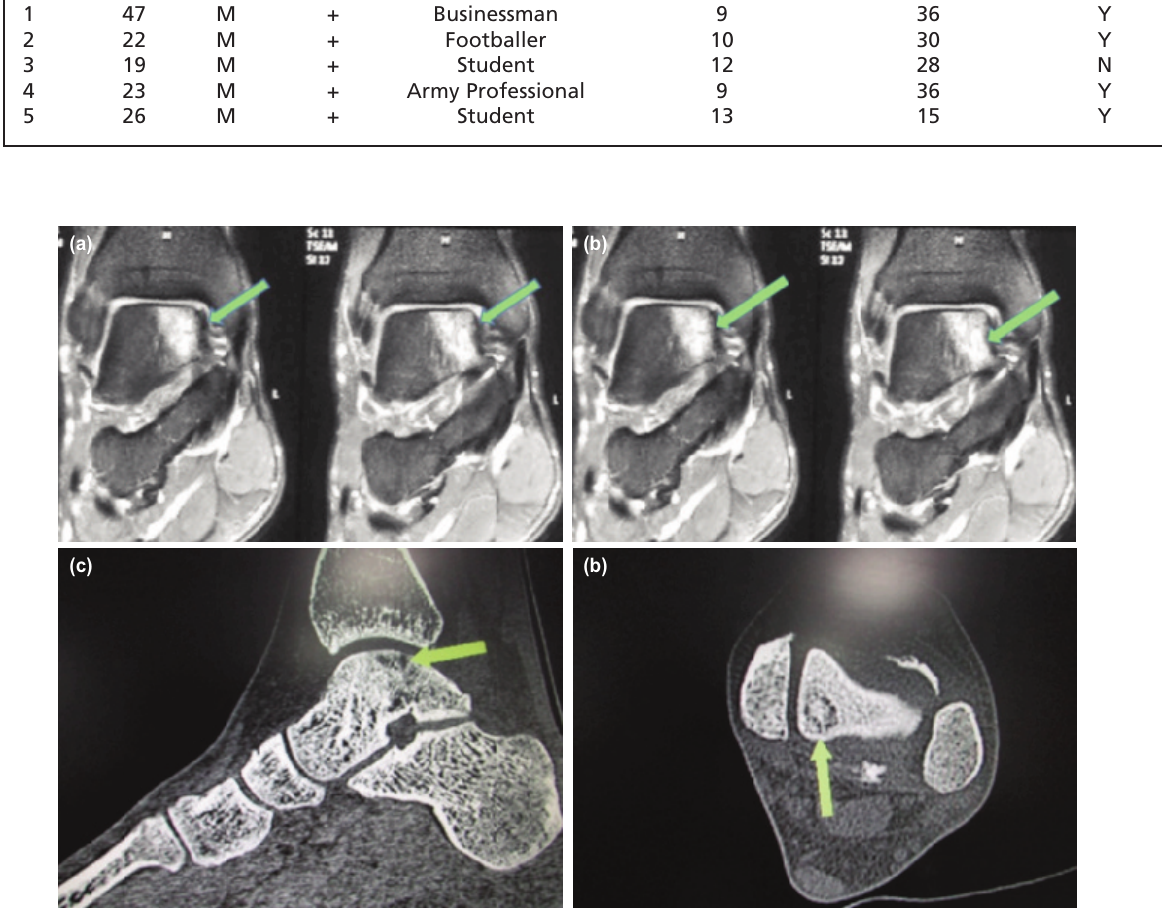
Imaging for diagnosis of OCD type V (a, b) magnetic resonance imaging; T1 and short-tau inversion-recovery (STIR) sequence Fig. 1: respectively depicting the site of OCD; (c, d) CT scan images showing subchondral location of cyst). Green and yellows arrows depict the lesion.